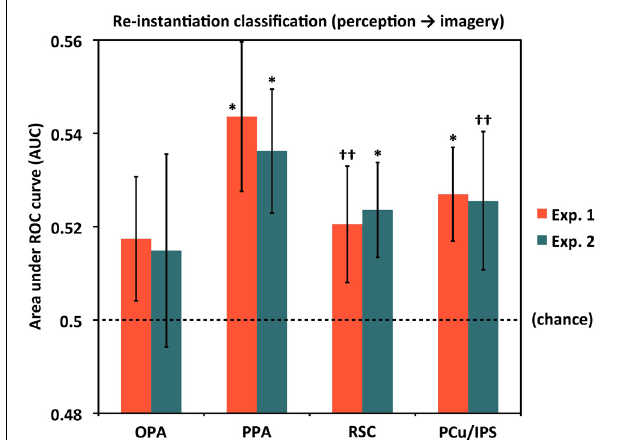
FIGURE 4 | Re-instantiation classification accuracy for distinguishing between individual scenes during mental imagery by ROI. For these analyses, classifiers were trained with perception trials and tested on imagery trials, whereas the results shown in Figure 3B were both trained and tested with subsets of the imagery trials. PPA, RSC, and PCu/IPS all exhibited re-instantiation accuracies that were above chance (AUC = 0.5), either significantly or at a trend level, in one or both experiments. OPA re-instantiation accuracies were numerically but not significantly above chance in both experiments. Analyses used 80 voxels per hemisphere per region, for a total of 160 voxels per region. ∗ p < 0 . 05, †† p < 0 . 13. Error bars represent s.e.m. See text and Table 1 for full statistics.